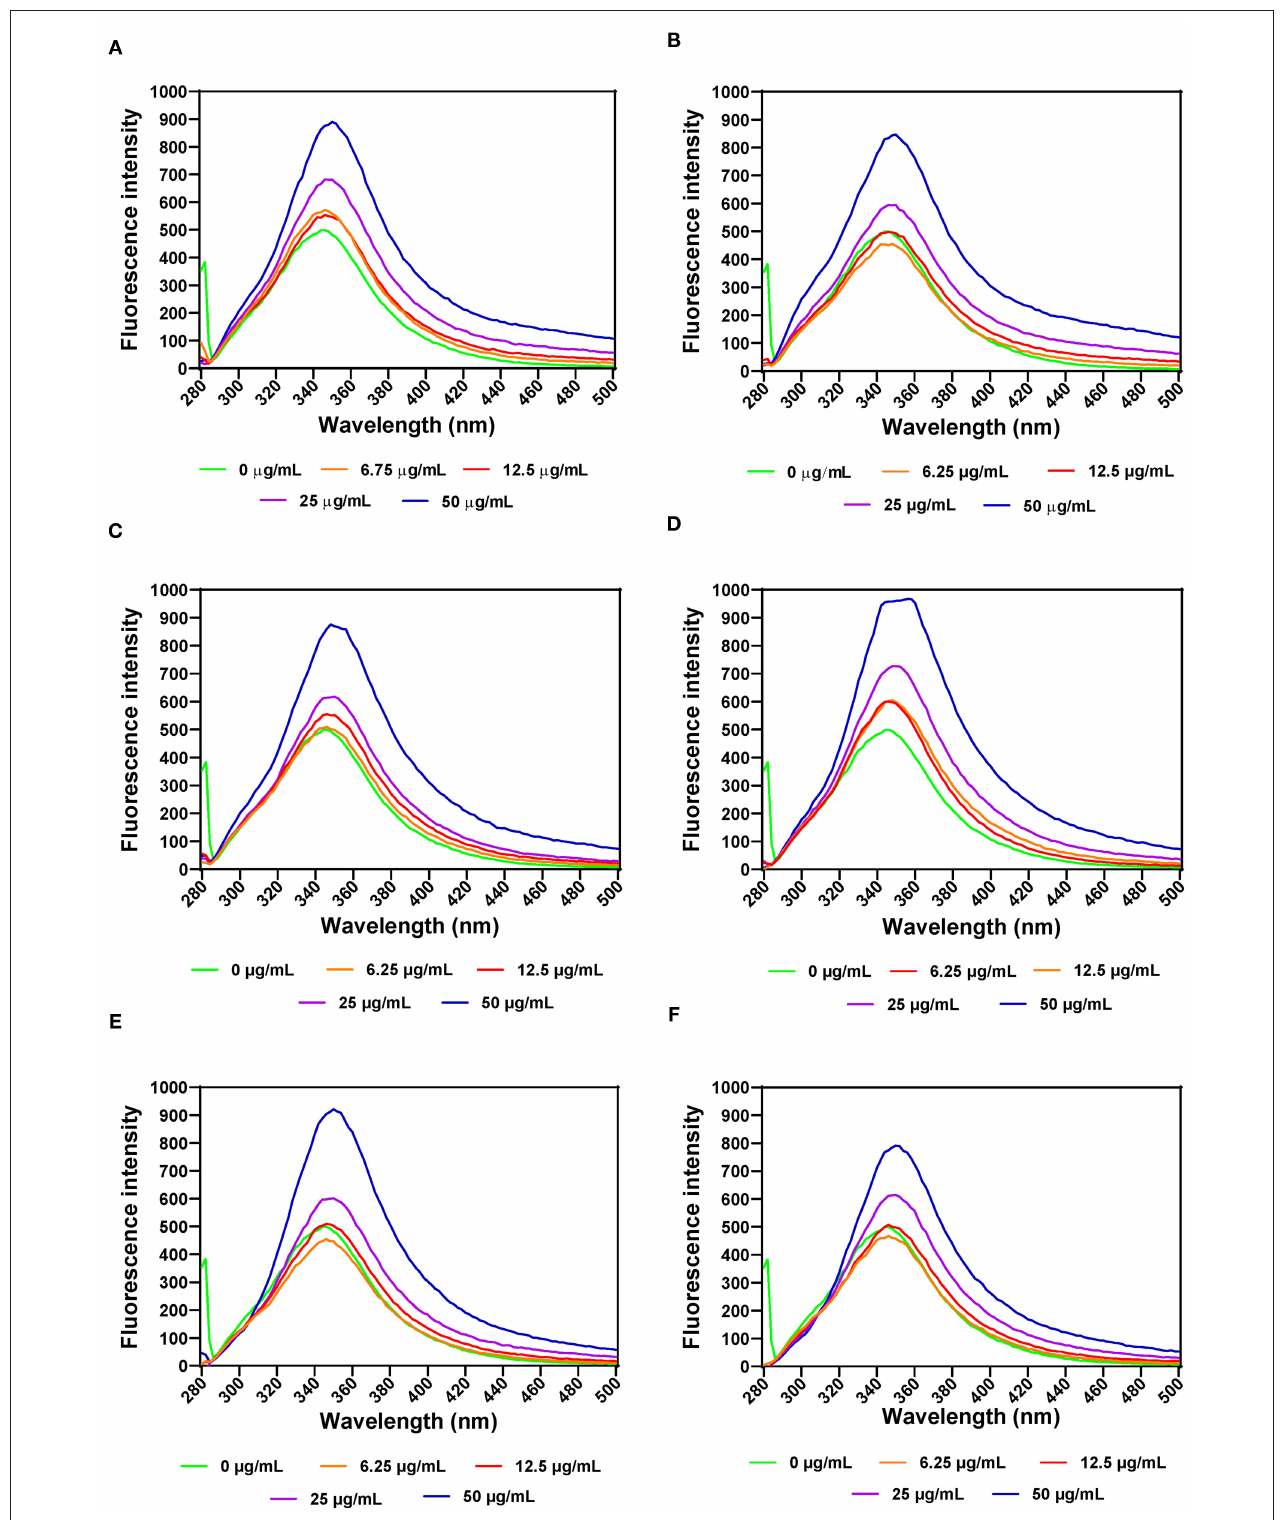
FIGURE 3 | Intrinsic fluorescence intensity of α - amylase in the presence of varied concentrations of leaf extracts from: (A) AV-20-T1, (B) AV-20-T2, (C) SM-20-T1, (D) SM-20-T2, (E) TO-20-T1, and (F) TO-20-T2. Plants were produced with nitrogen fertilizer (20 kg N/ha), which was applied at (T1) or after (T2) planting.